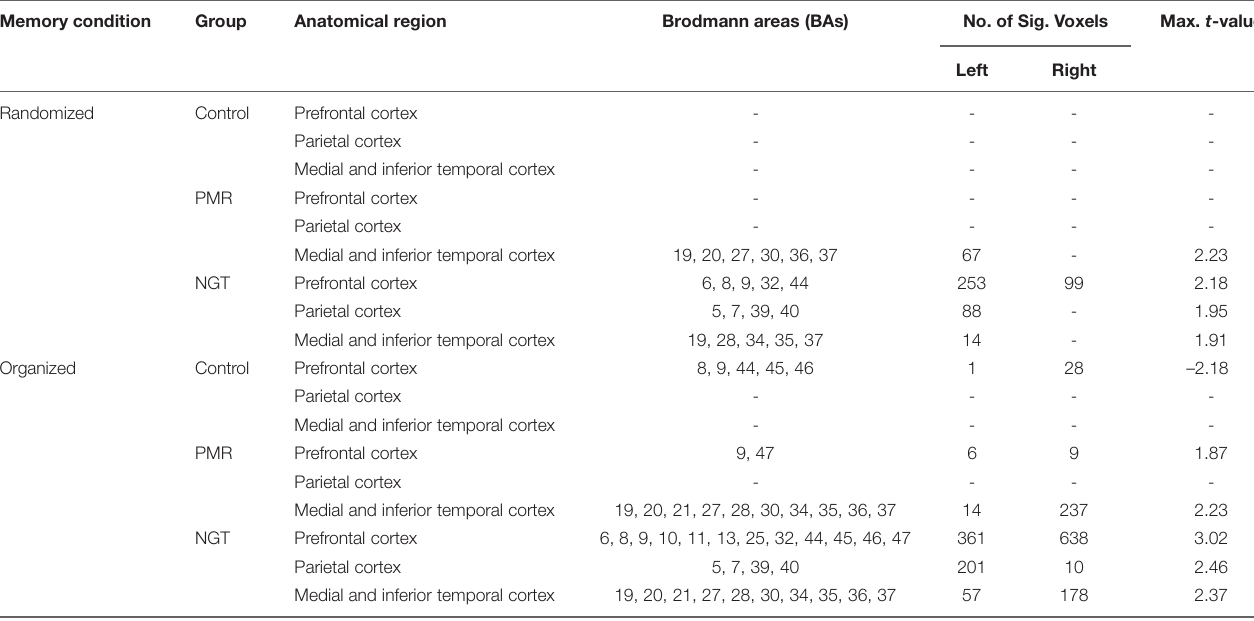
TABLE 3 | Cortical voxels showing significant post-training changes in theta source activity across three groups and two memory conditions. Memory